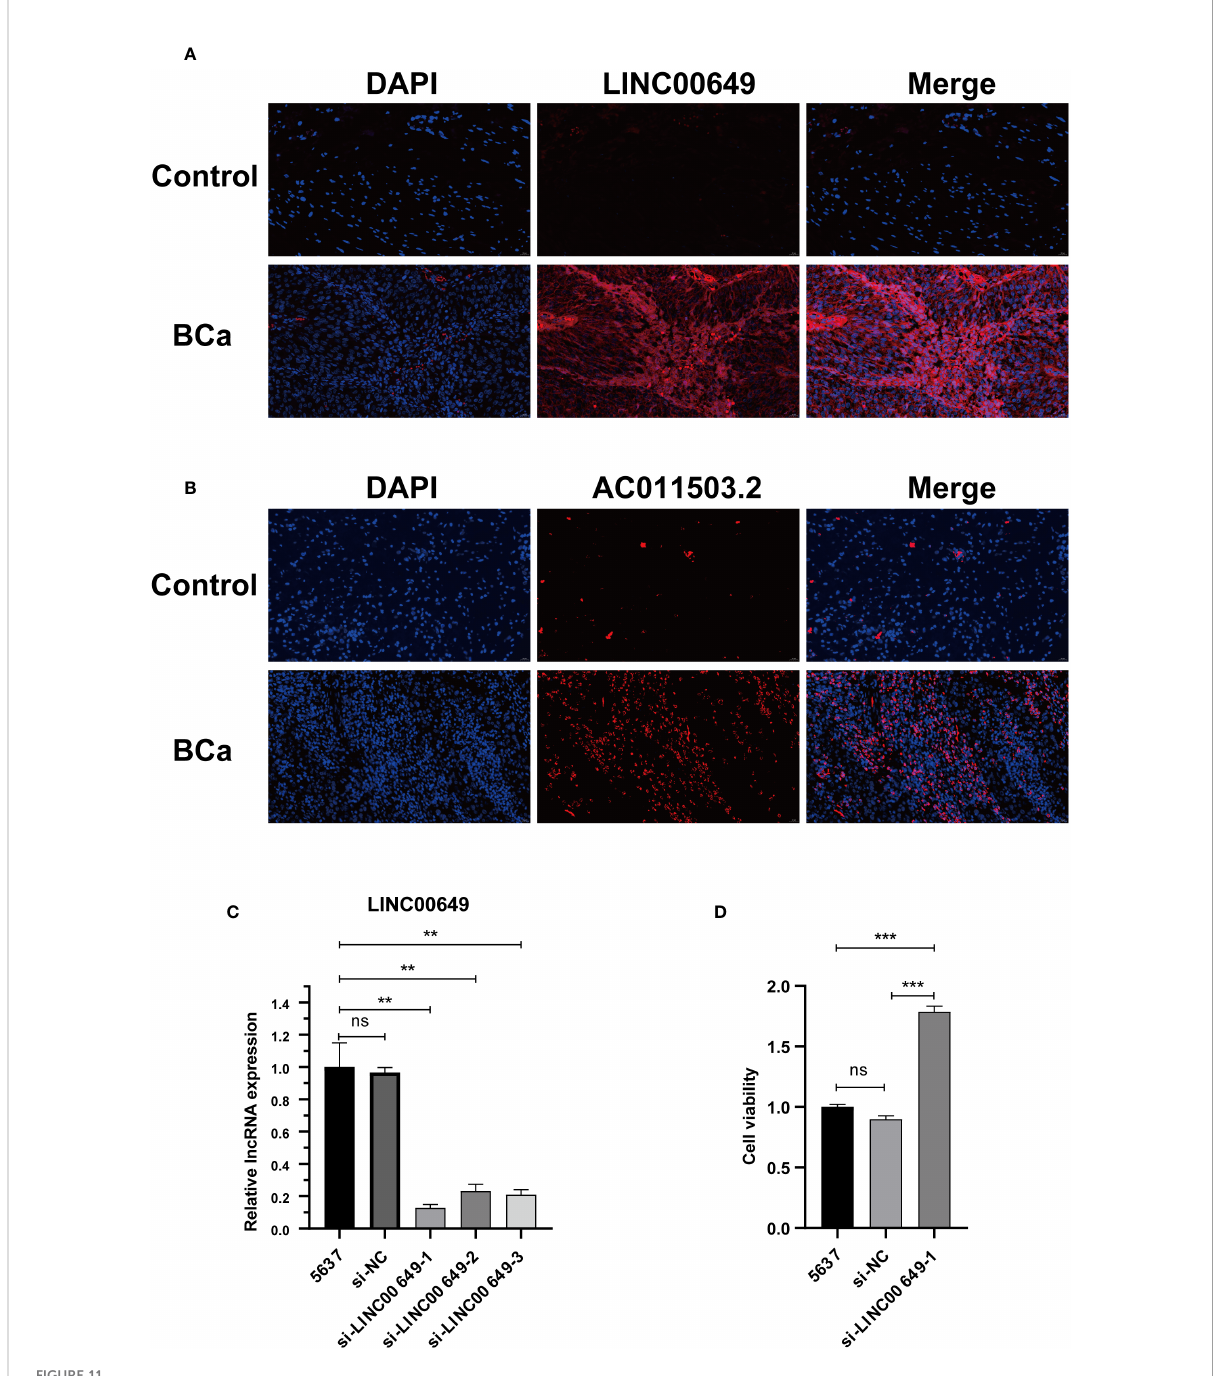
FIGURE 11 Validate the expression of model lncRNAs in tissues and explore the effect on 5637 cell proliferation. (A) RNA-FISH showed that LINC00649 was mainly distributed in the cytoplasm. (B) RNA-FISH showed that AC011503.2 was mainly distributed in the nucleus. (C) The effects of si- LINC00649 on LINC00649 expression in 5637 cells. (D) The effects of knockdown of LINC00649 on the proliferation viability of 5637 cells. ** P > 0.01, *** P >0.001, ns, not signi fi